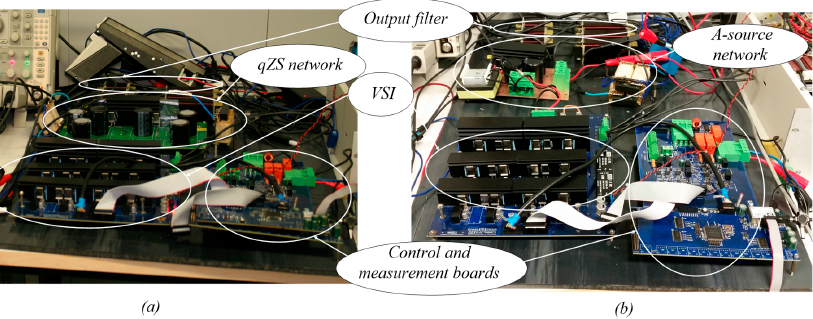
Figure 16. Experimental setup: ( a ) The qZS three ‐ phase inverter and ( b ) the A ‐ source three ‐ phase inverter. Selected topologies were compared by the same parameters of the input voltage, load, capacitors, and input inductor value. The input voltage was equal to 183 V with a RMS ac output voltage of about 110 V.